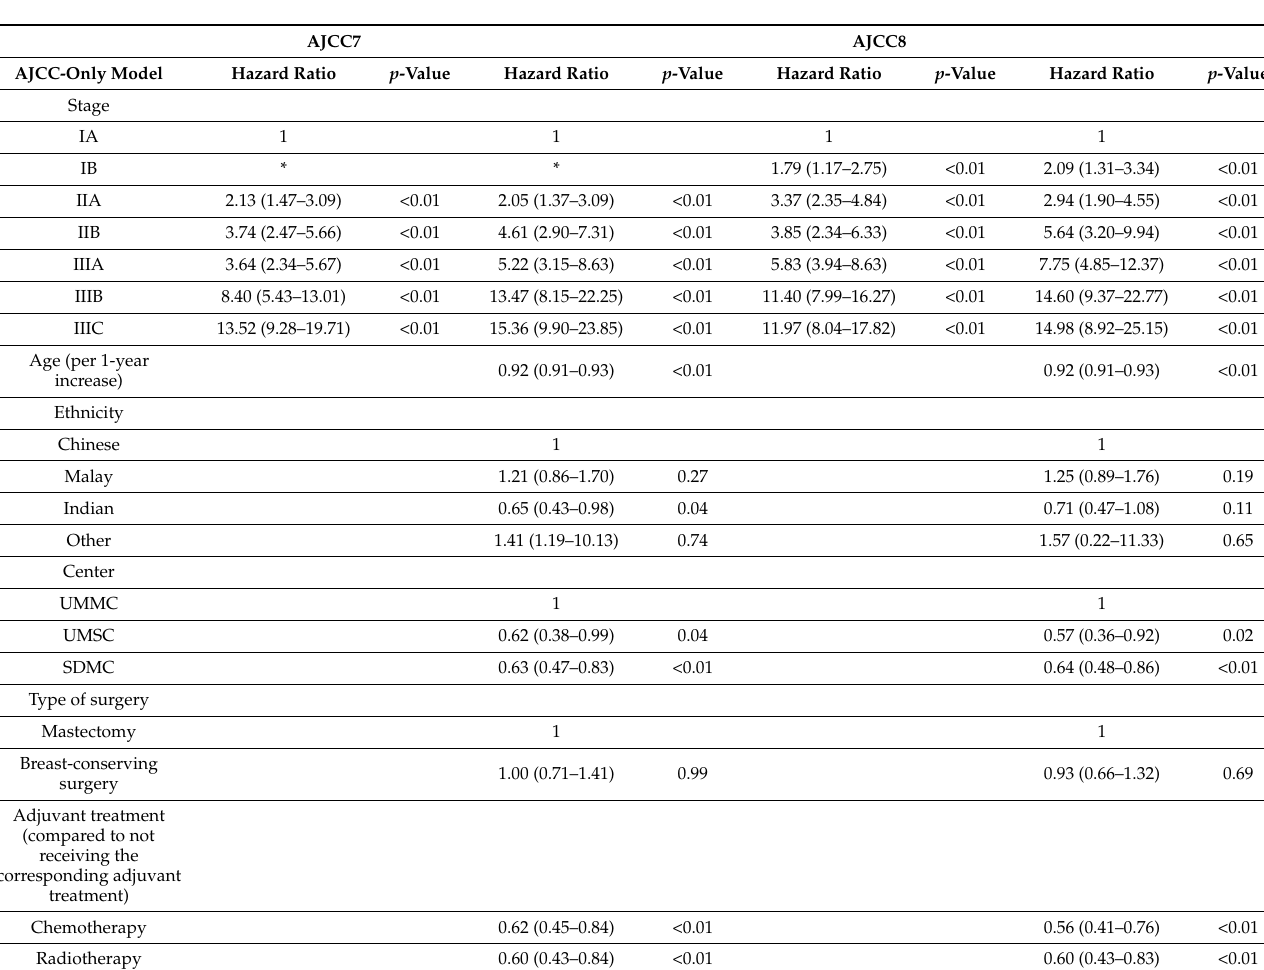
Table 5. Association between stage and overall survival among patients with breast cancer by staging system (AJCC7 and AJCC8), and concordance for AJCC7 and AJCC8 staging to predict relative survival. AJCC7